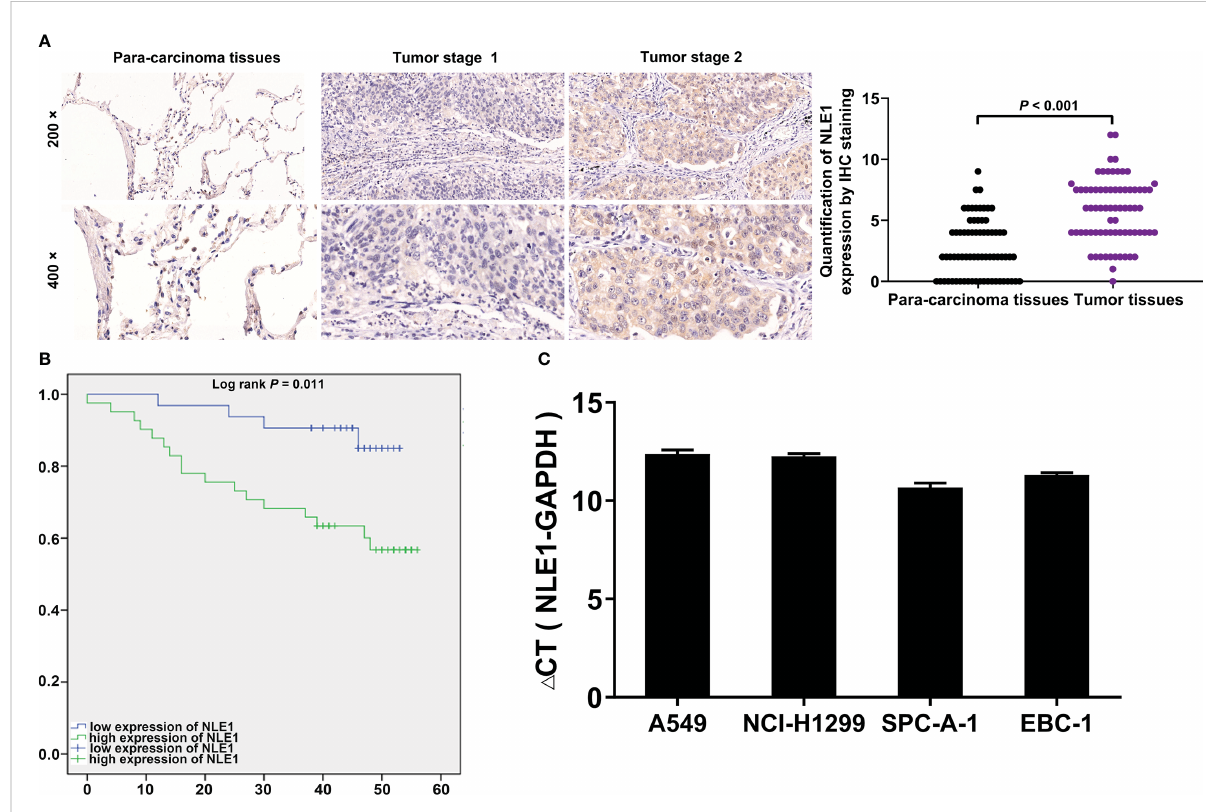
FIGURE 1 NLE1 was up-regulated in non-small cell lung cancer. (A) The expression levels of NLE1 in NSCLC tumor tissues and para-carcinoma tissues were determined by IHC staining. IHC scores of all tissue samples were used for statistical analysis. (B) Kaplan-Meier analysis showed that higher NLE1 expression was correlated with a shorter overall survival. (C) The expression levels of NLE1 in a panel of human NSCLC cell lines were determined by qRT-PCR. Results were presented as mean ± SD (n ≥